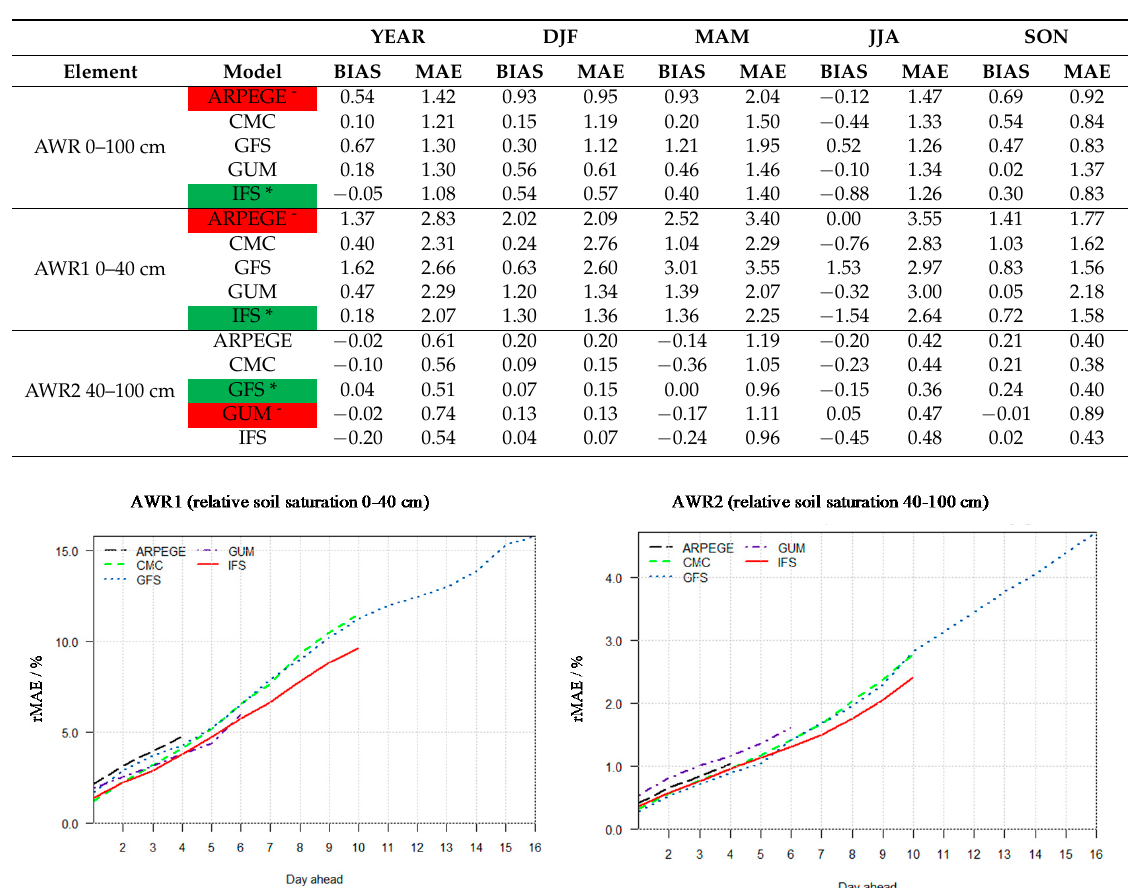
Table 3. Validation characteristics of the SoilClim outputs (AWR—relative soil saturation) for individual seasons and 5 NWP models as input (green and asterisk = the best model, red and dash = the worst, estimated based on MAE for annual values) and for the three days ahead forecast. Individual NWP models are explained in Table 1.